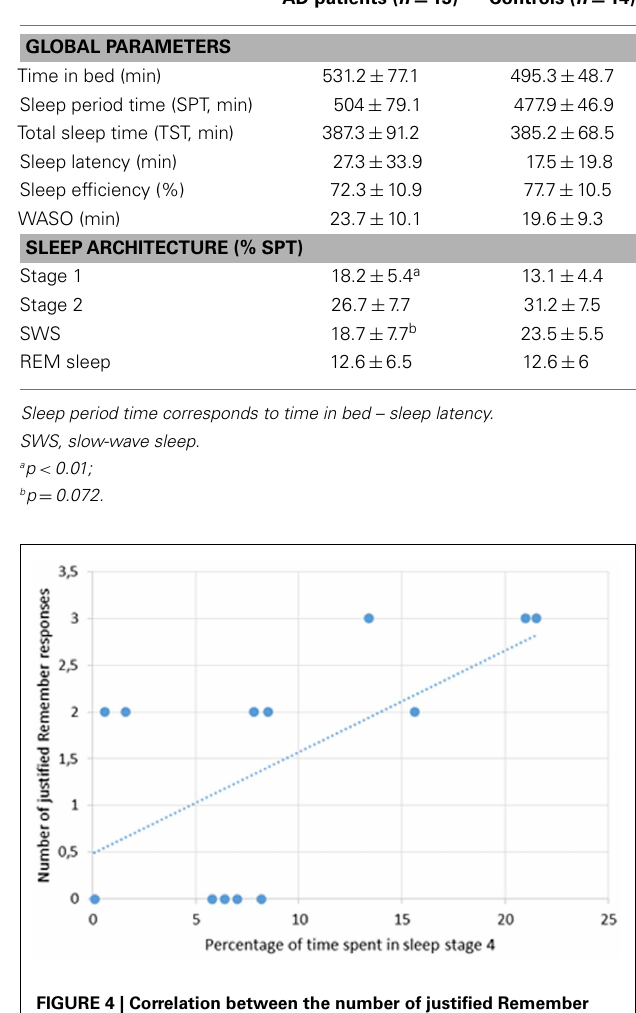
FIGURE 4 | Correlation between the number of justified Remember responses for the yesterday sub-period and the percentage of time spent in sleep stage 4 inAD patients